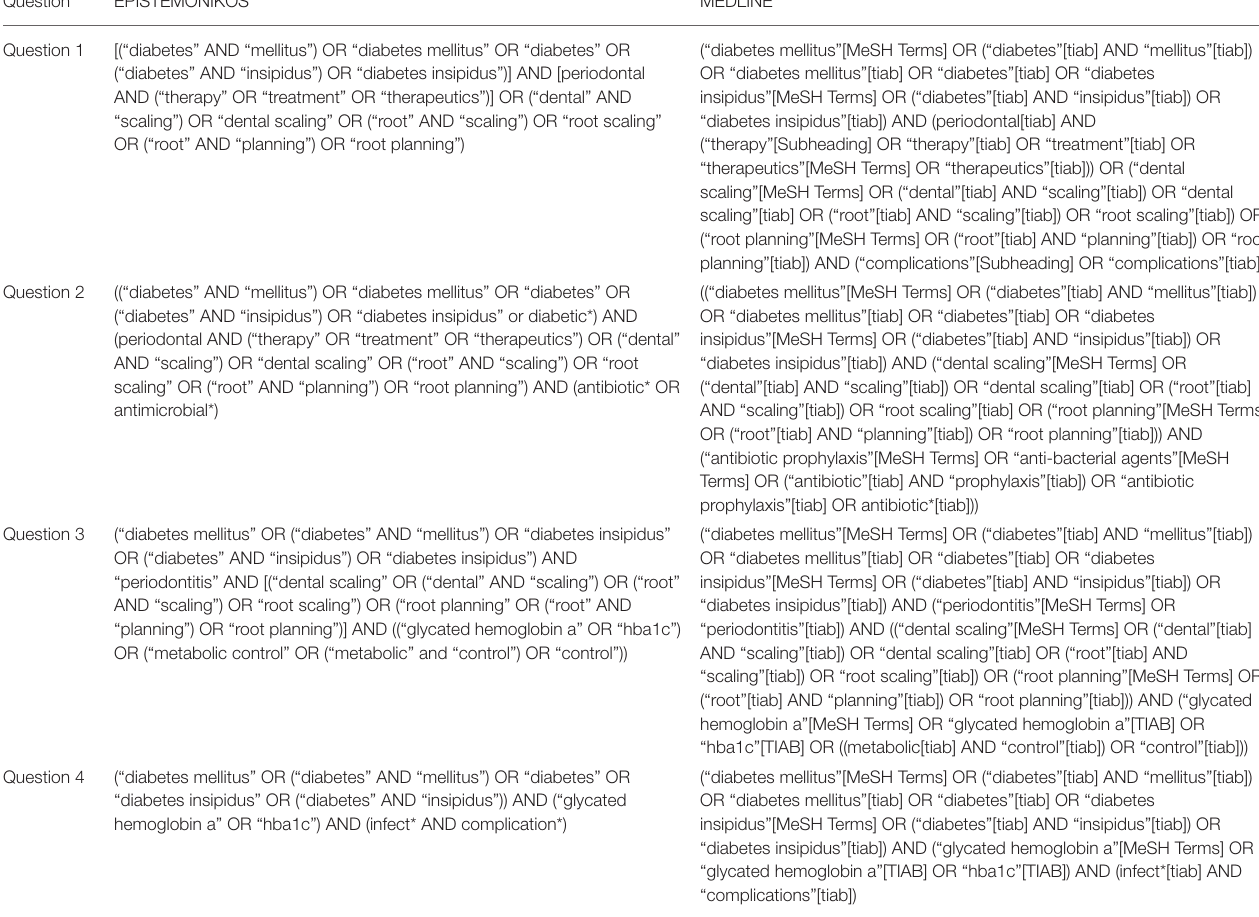
TABLE 1 | Search strategies.